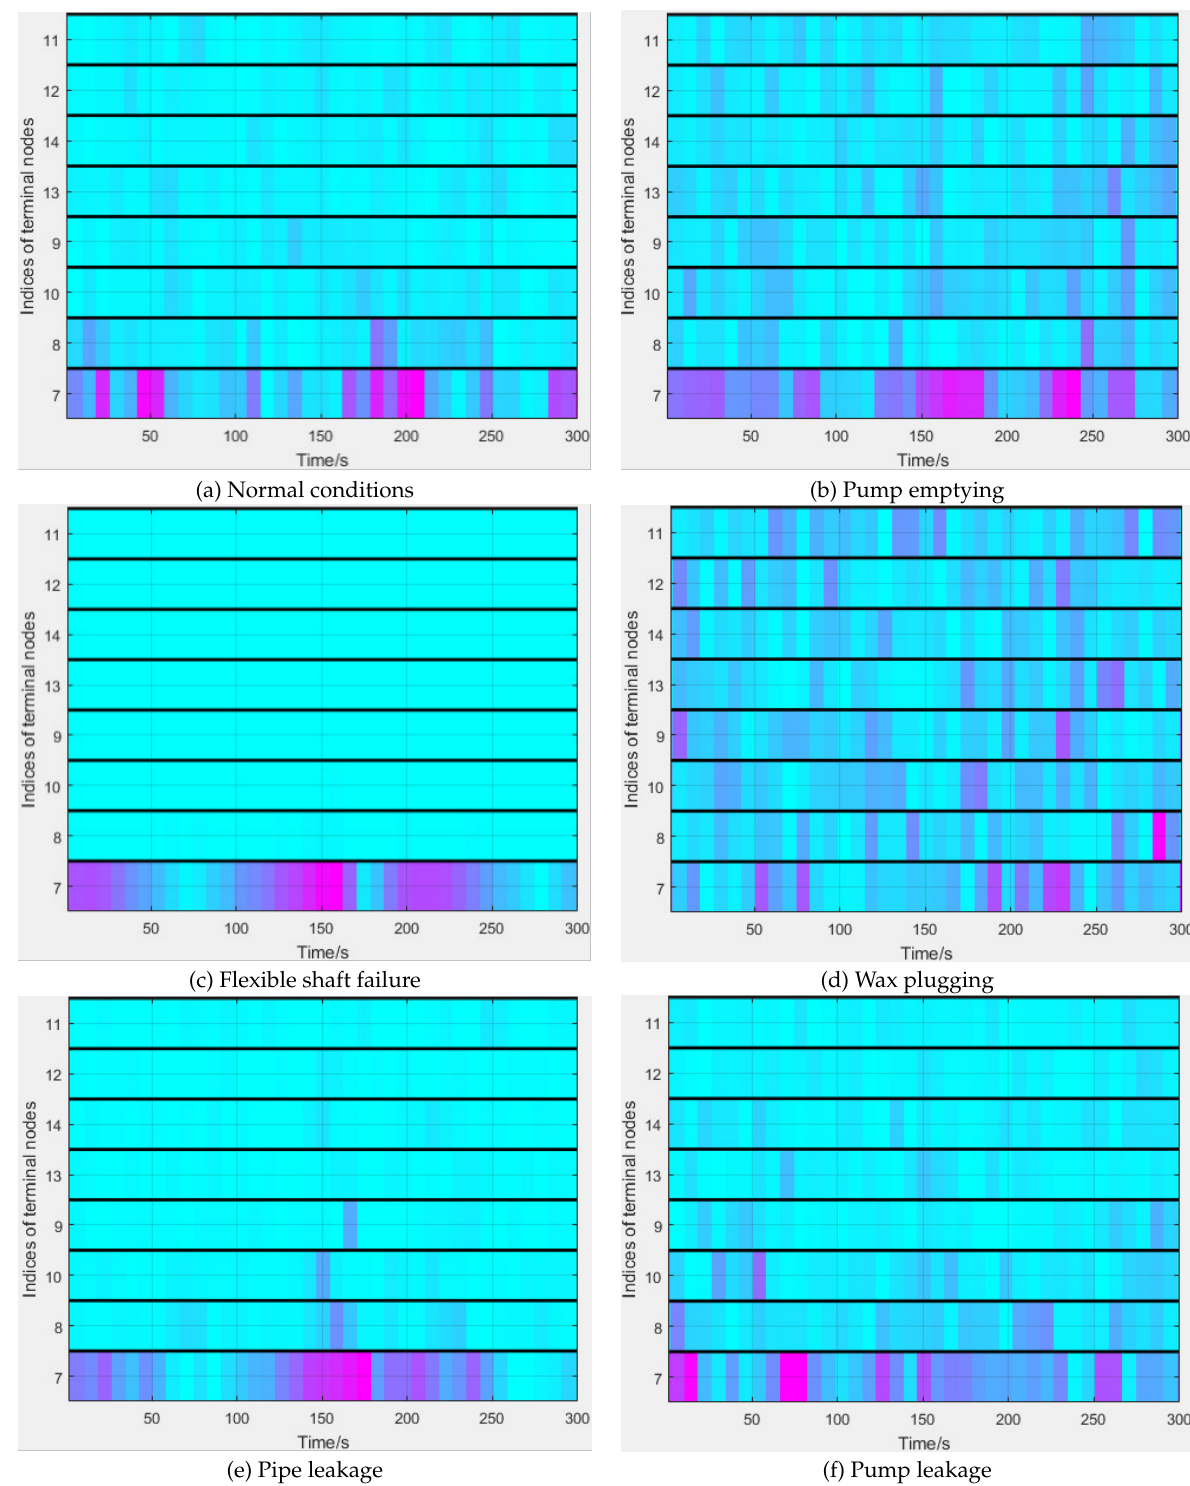
Fig. 6. Time-frequency diagram of power under six working